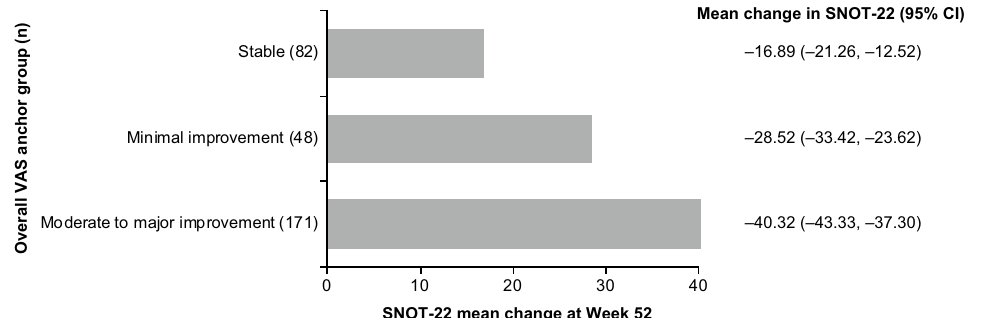
Fig. 3 CDF plot: change from baseline in SNOT-22 total score by overall VAS anchor. Overall VAS anchor groups were defined by change in overall VAS symptom score from baseline to Week 52: moderate to major improvement: improvement: 2 to > 4-point change in VAS score; limited improvement or worsening (stable): > ≤ − − Cumulative distribution function, SNOT-22 Sino-nasal outcome test-22, VAS Visual analogue